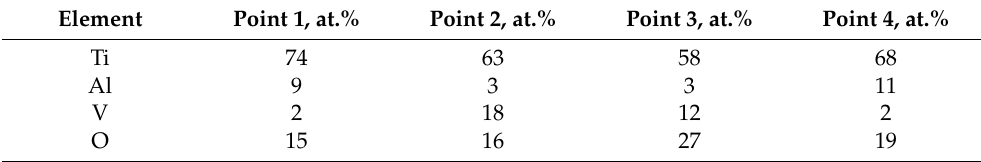
Table 2. Elemental composition of the Ti-6Al-4V sample at the points shown in Figure 7a. Element Point 1, at.% Point 2, at.% Point 3, at.% Point 4, at.% Ti